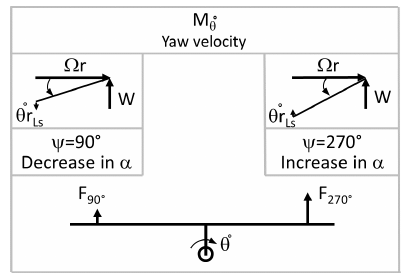
Figure 3. Aerodynamic mechanism for yaw damping for a down- wind